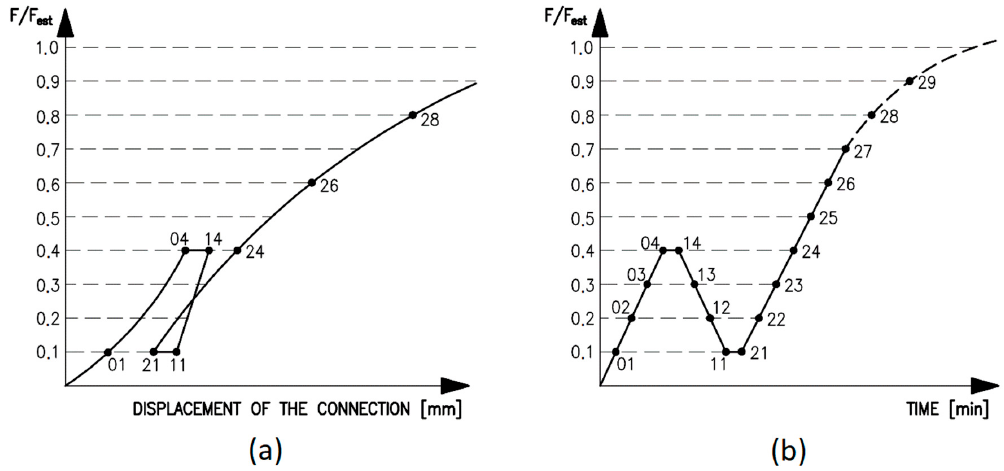
Figure 7. ( a ) Idealized load–displacement diagram and measured values; ( b ) The course of testing during time.